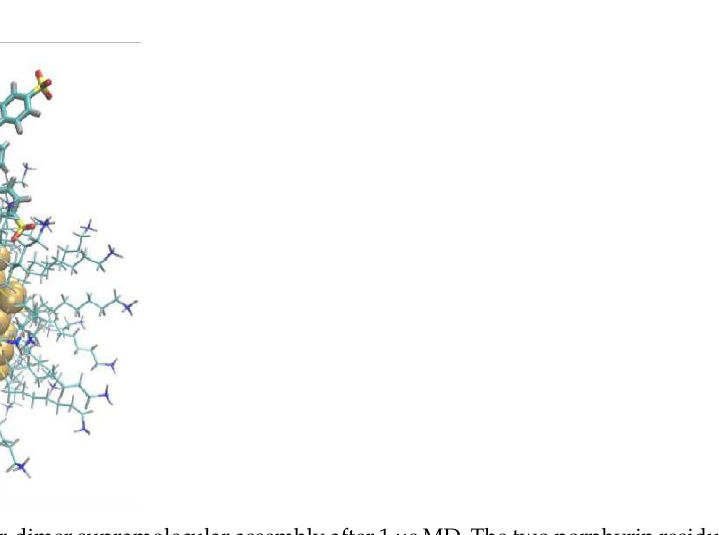
Figure 8. The nanocluster-dimer supramolecular assembly after 1 µ s MD. The two porphyrin residues are both radially oriented with respect to the Au 144 L 60 cluster.